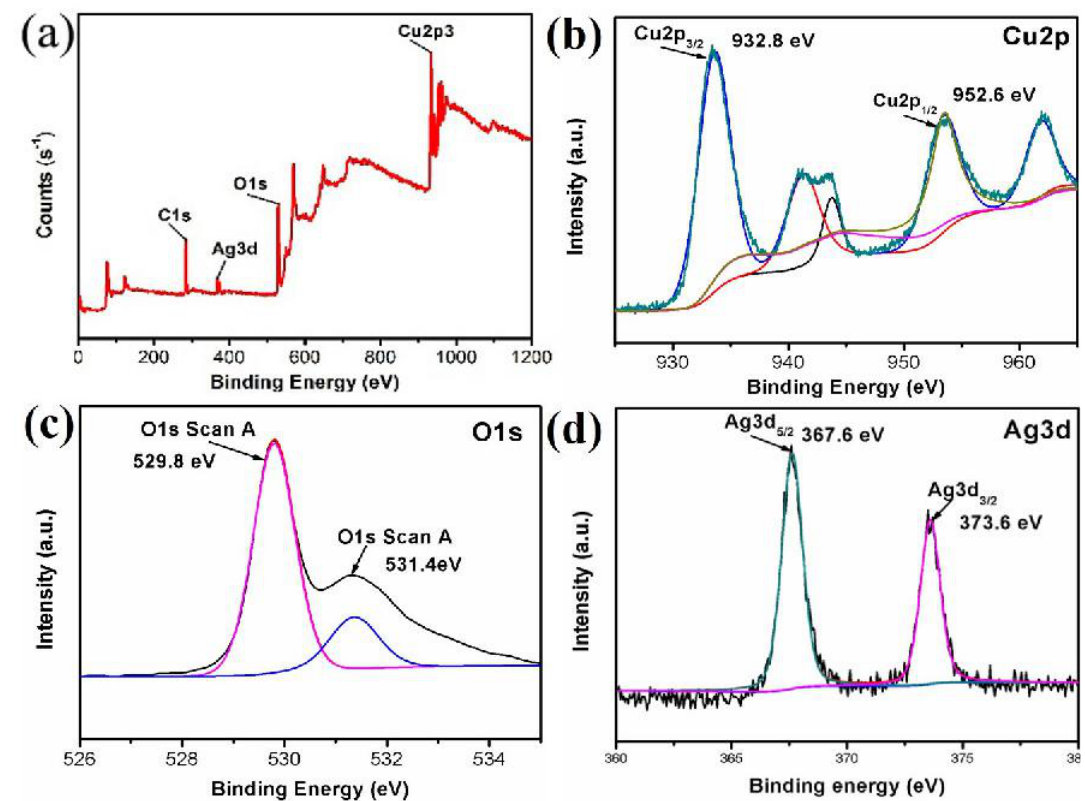
Figure 2. X-ray photoelectron spectroscopy (XPS) analysis of prepared Ag@CuO FM: ( a ) survey scan; ( b ) Cu 2p; ( c ) O 1s; ( d ) Ag